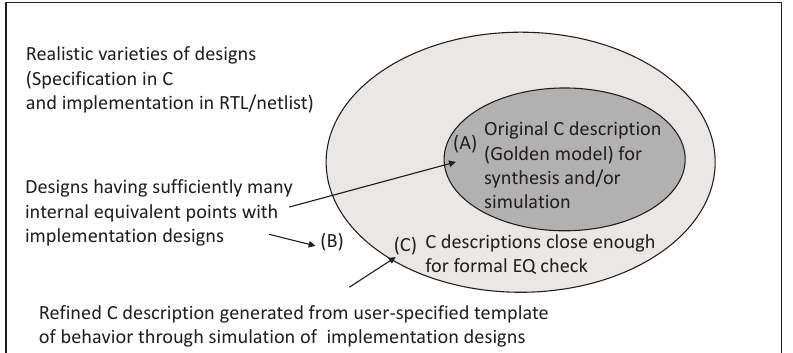
Figure 4. The basic idea of the proposed equivalence checking method.